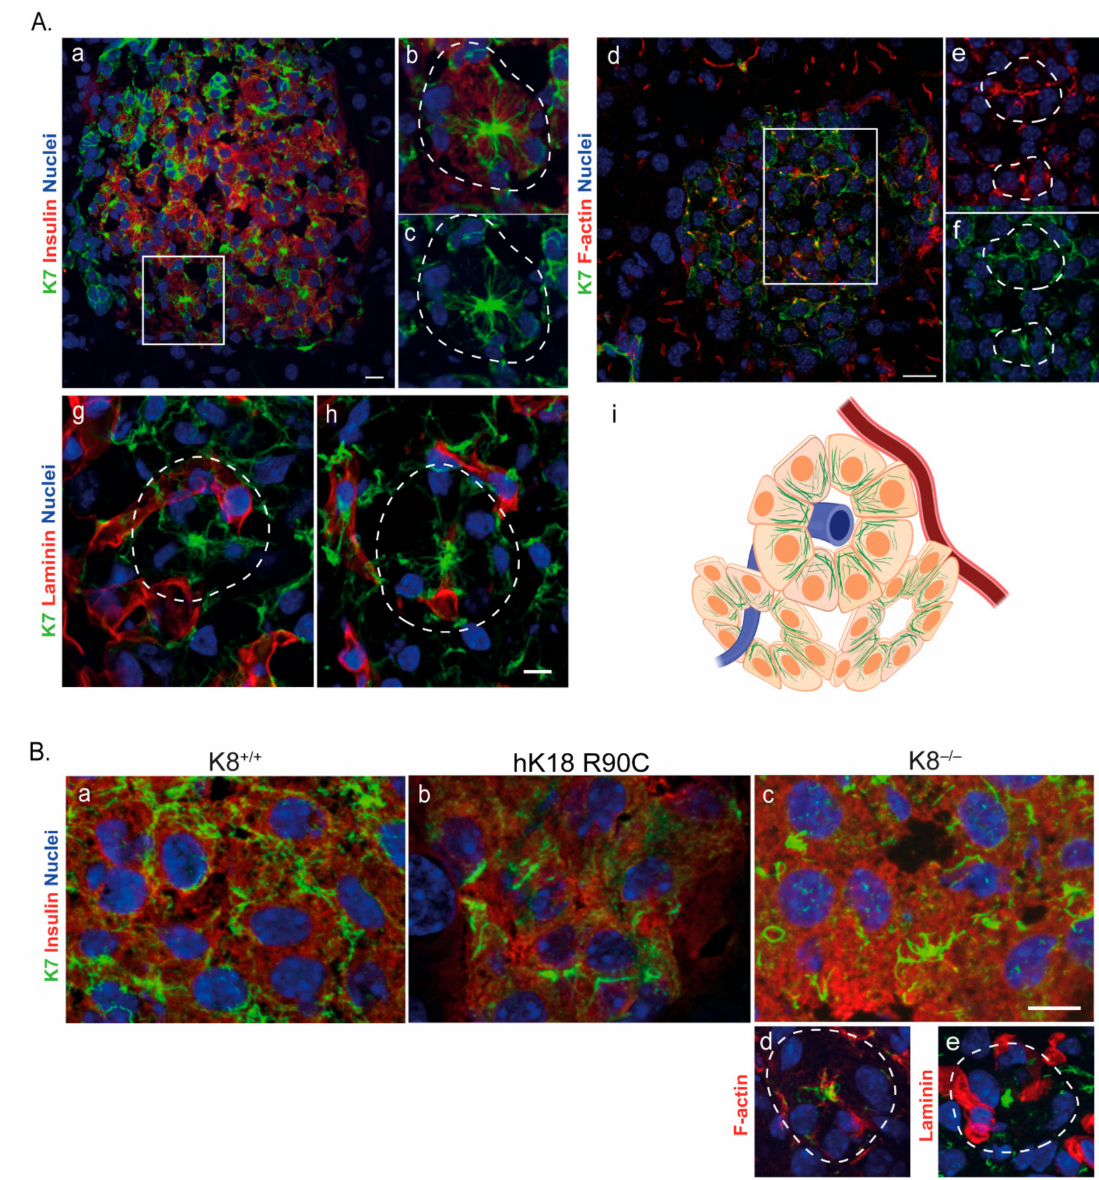
Figure 2. K7 is mainly expressed apicolaterally in K8 +/+ islet β -cells, as well showing a cytoplasmic filament network which is fragmented in the absence of K8 (K8 − / − ) or disruption of K18 (hK18 R90C) filaments. ( A ) Pancreatic tissue sections from K8 +/+ mice were immunostained for K7 (green), insulin (red) and nuclei (blue). The merged image of double staining of islet ( a ) and the higher magnification individual separate images of the islet rosette ( b , c ), showed the K7 expression as thick bundles near the apical (center of rosette) and lateral side of β -cells. The immunostaining of islets for K7 (green) and F-actin (red) in merged image ( d ) and individual higher magnification rosettes ( e , f ), showed a similar enrichment in apicolateral side of the cells for K7 and F-actin. The immunostaining of islets for K7 (green) and laminin (red) in higher magnification rosettes ( g , h ), showed that K7 filaments are not found on the basal side of β -cells (identified by the laminin-staining). Boxes in a and d indicate areas enlarged in b, c, and e, f respectively. Dotted lines indicate rosettes. Scale bar = 20 µ m. The schematic ( i ) shows the K7 β -cell localization in islet rosettes. The venule (blue) in the center and arteriole (red) near the periphery of the rosettes are indicated. K7 filament bundles (green) are enriched in the apical side towards the center of the rosette and the lateral side of β -cells, while are away from the basal side on the periphery of the rosette. ( B ) Pancreatic β -cells stained for K7 (green), insulin (red) and nuclei (blue) in hK18 R90C mouse islets ( b ), showed that K7 was mostly seen as dot-like structures with only scarce filaments. Lateral and cytoplasmic K7 filaments in K8 − / − mice ( c – e ), were also fragmented compared to K8 +/+ ( a ). Dotted lines indicate rosettes. Scale bar = 10 µ m. n = 2 mice per